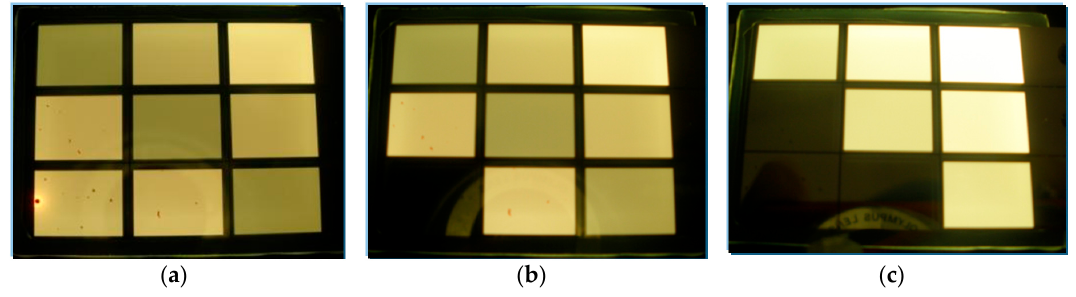
Figure 5. The test sample of our novel design. ( a ) Three pairs of anode/cathode/electrode are all connected; ( b ) anode3 is open; ( c ) anode2 and anode3 are open.